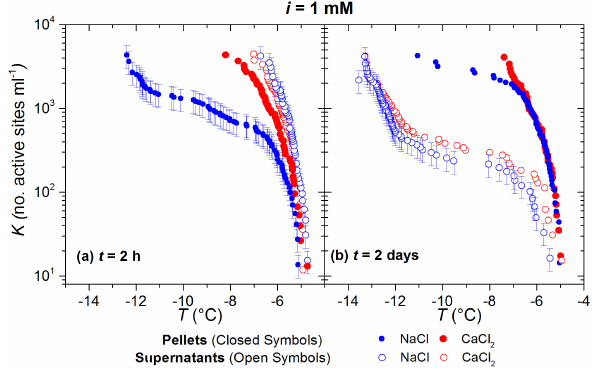
Figure 3. Effect of electrolytes at an ionic strength of 1mM on the uptake of P-INPs to the clay surface with a contact time of (a) 2h and (b) 2 days. Initially, in (a) it can be seen that uptake to the clay is greater in the presence of Ca 2 + (closed red circles) compared with Na + (closed blue circles), but after 2 days (b) , the extent of adsorption is the similar regardless of the salt used. After 2 days, depletion of the free protein is extensive, with on the order of 90% of INPs active at − 7 ◦ C found to be associated with the clay.